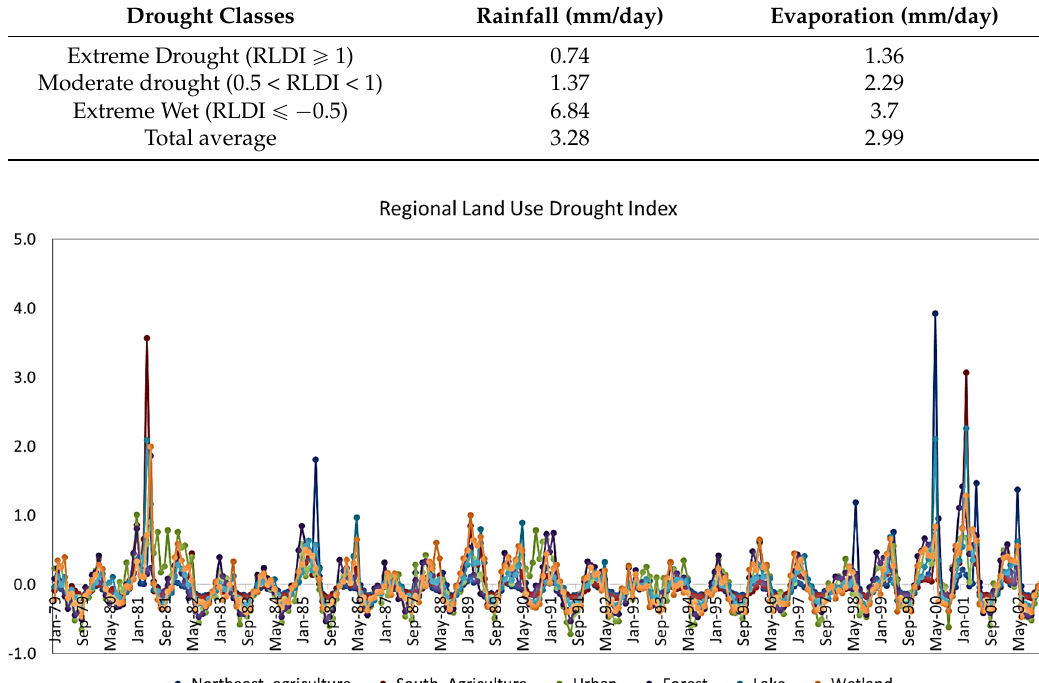
Figure 11. Time Series for Monthly RLDI in the Study Areas.